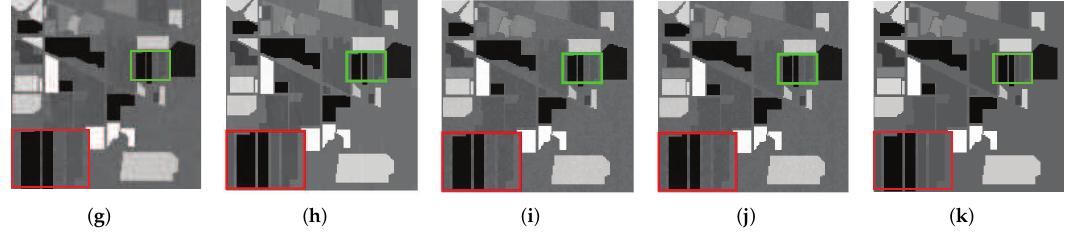
Figure 5. The comparison of the effect of band 129 before and after denoising in the simulated data experiment: ( a ) original image, ( b ) noisy image, ( c ) WNNM, ( d ) LRMR, ( e ) WSNM, ( f ) LRTV,